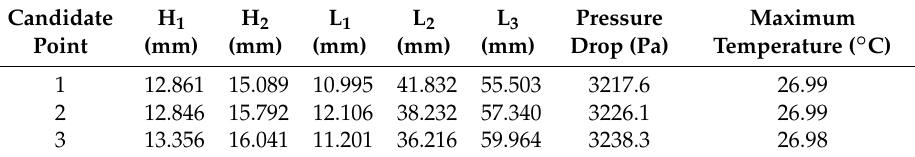
Table 9. Candidate points.